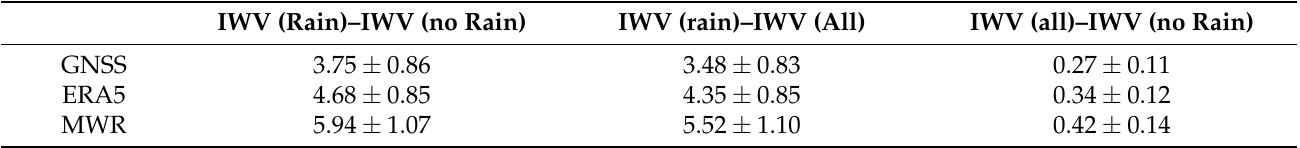
Table 3. Mean differences of IWV (mm) and their standard deviations derived for the different atmospheric states at Bern using the monthly means of Figure 5. Rain periods are indicated by ILW ≥ 0.4